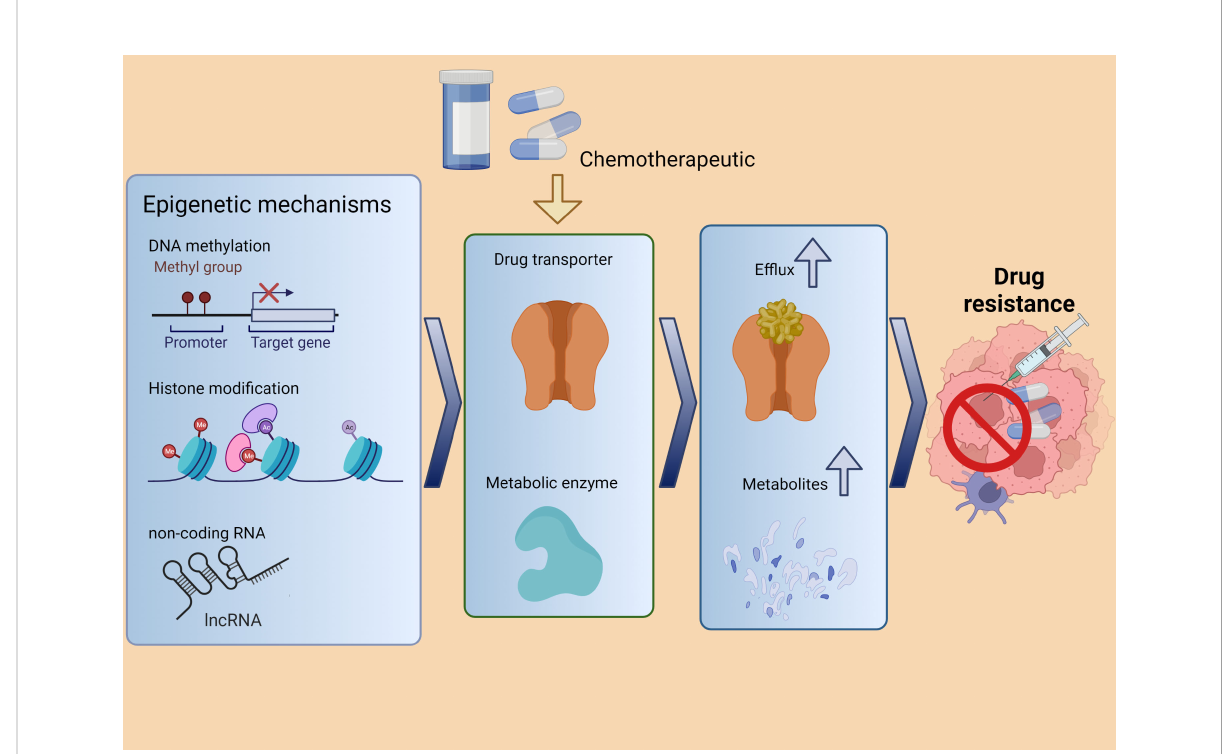
FIGURE 4 The epigenetic processes involved in cancer chemoresistance includes DNA methylation, histone acetylation, and lncRNA interaction. These processes regulate drug transporters and metabolic enzymes, promoting drug resistance. Adapted from Zhou et al.